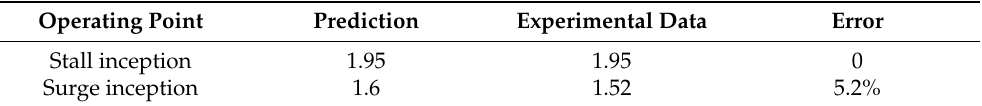
Table 14. Comparison of the stall and surge inception points between predictions and experiments.